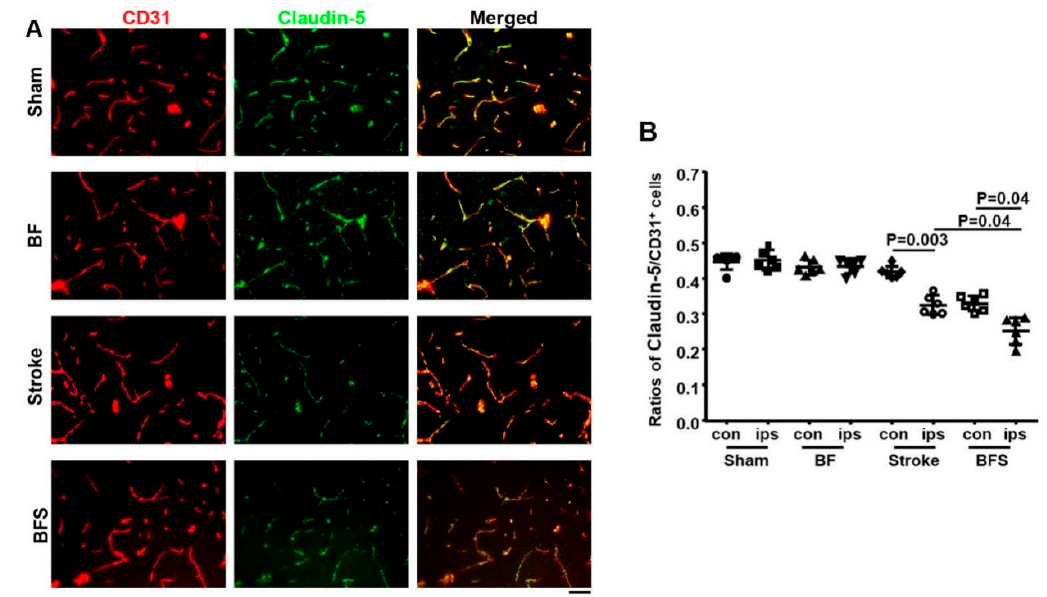
Figure 3. BF enhanced the reduction of claudin-5 protein in the ipsilateral hippocampi of stroke mice. ( A ). Representative images of sections stained with anti-CD31 (red) and anti-claudin-5 (green) antibodies. Scale bar: 50 µm. ( B ). Quantification of claudin-5 and CD31 ratios. N = 6. con: contralateral to stroke injury. ips: ipsilateral to stroke injury. BFS: BF 6 h before stroke.